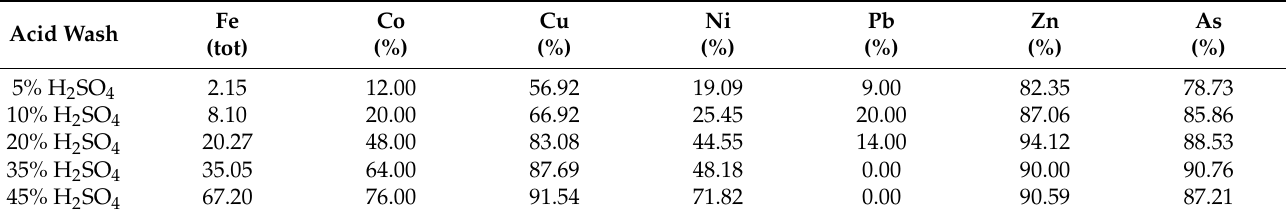
Table 9. Base metal recovery to solution.